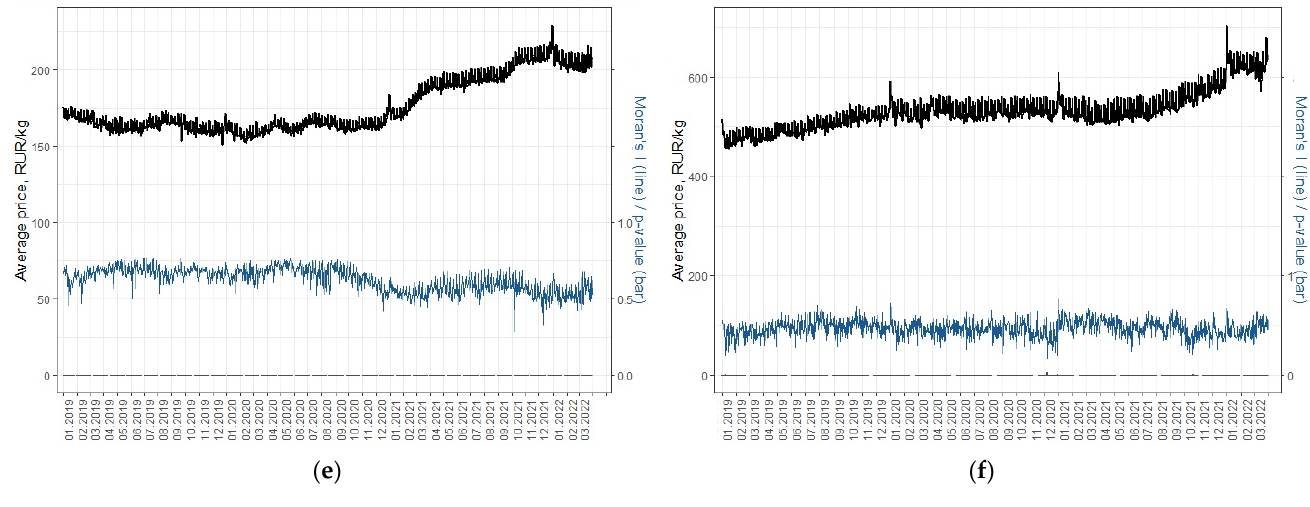
( e ) ( f ) Figure 2. Daily average regional price of Pasta ( a ), Potatoes ( b ), Sugar ( c ), Candies ( d ), Poultry meat ( e ), Butter ( f ) and global Moran’s I b index (based on binary contiguity matrix), from 1 January 2019 to 31 March 2022. Table 4. Tests results for seasonality in spatial autocorrelation (based on binary contiguity matrix). Pasta Potatoes Sugar Candies Poultry Meat Butter Weekly